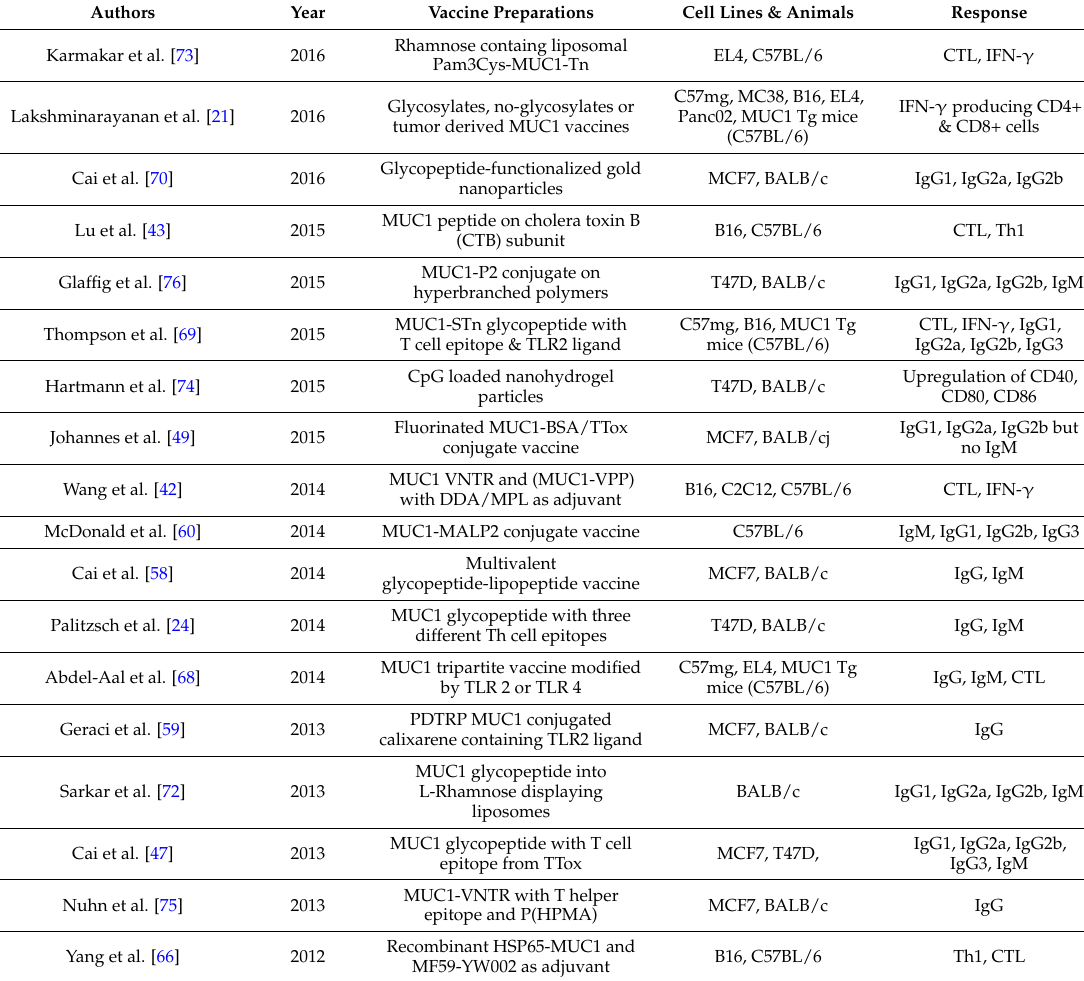
Table 1. Different strategies for producing anti-MUC1 immunological